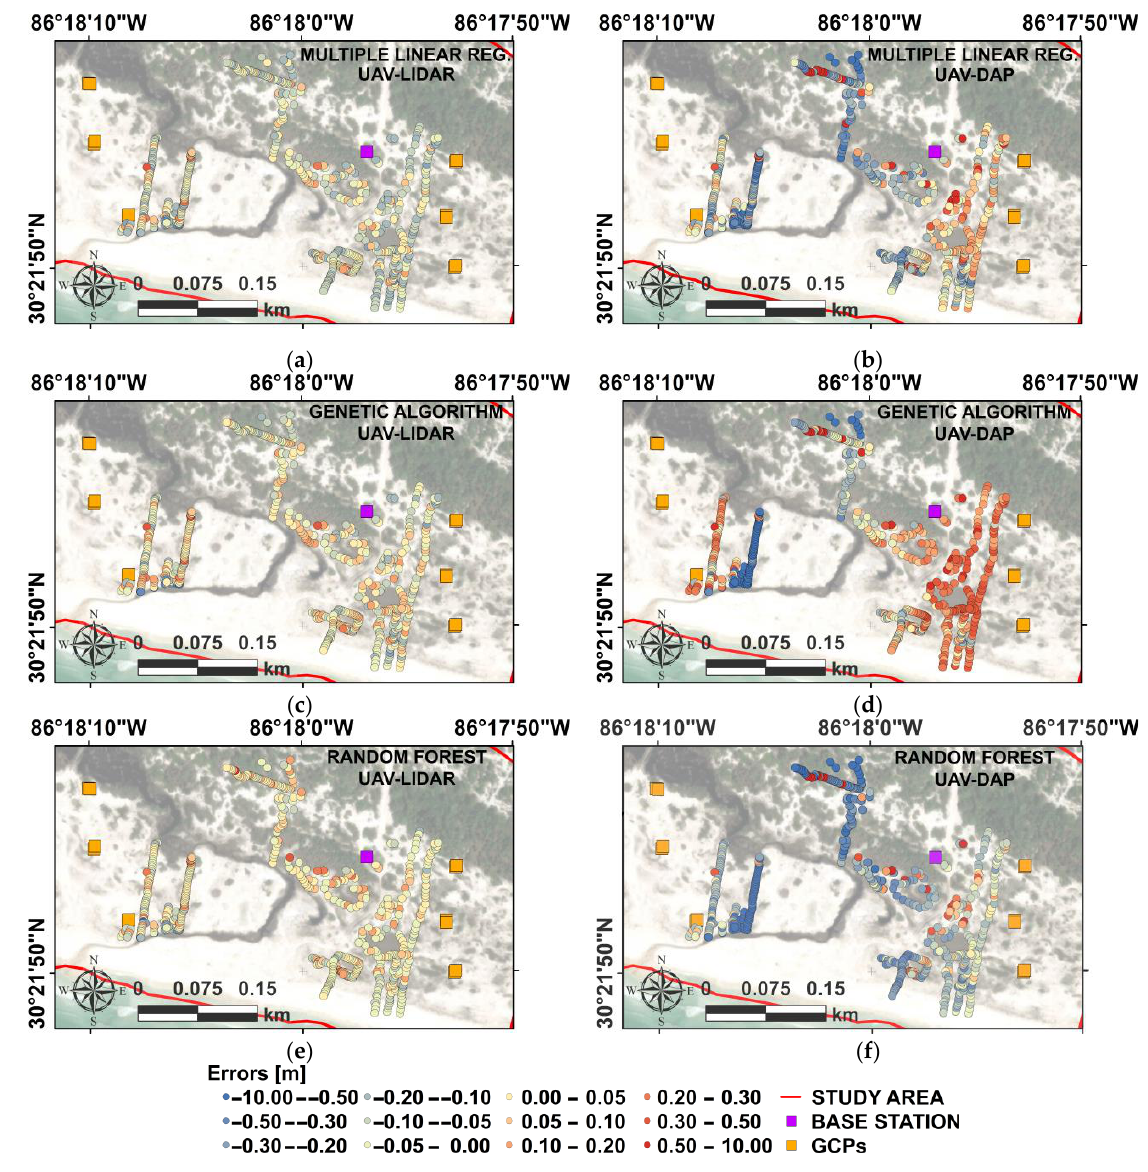
Figure 8. Spatial distribution of the estimation error obtained by applying the multiple linear regression ( a , b ), the genetic algorithm ( c , d ), and the random forest ( e , f ) methods to the UAV – LIDAR point cloud, transformed using the regression plane method (first column), and the non-transformed UAV – DAP point cloud (second column). The background of the images in the first rows is the ArcGIS world imagery map. The orange squares indicate the location of the ground control points. The violet square indicates the location of the base station.